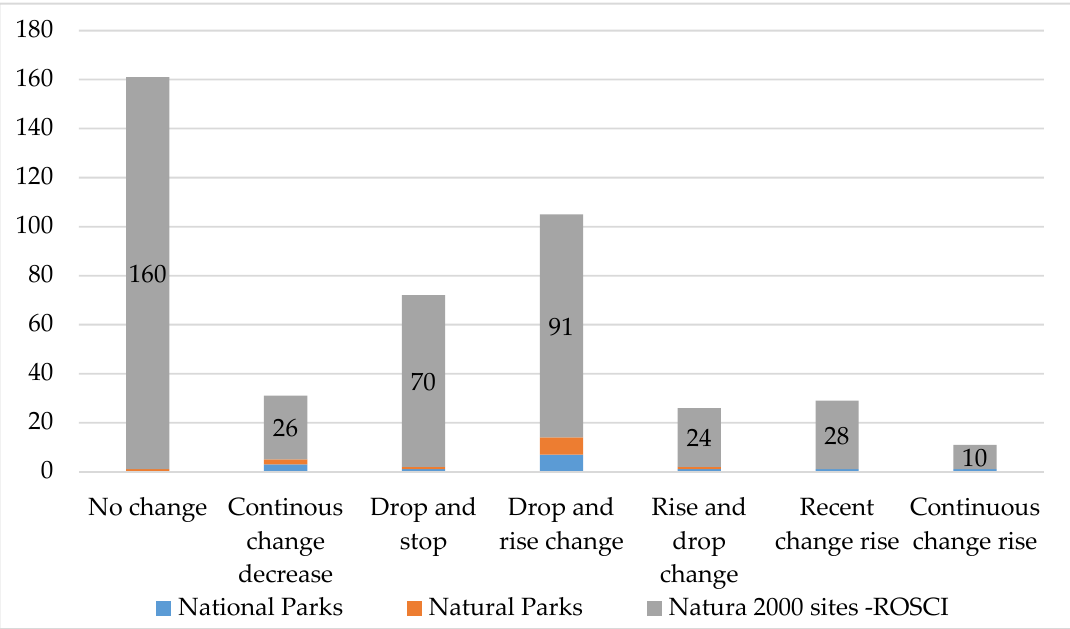
Figure 10. Patterns of dynamic behavior encountered in Natural Parks, National Parks and ROSCI sites.